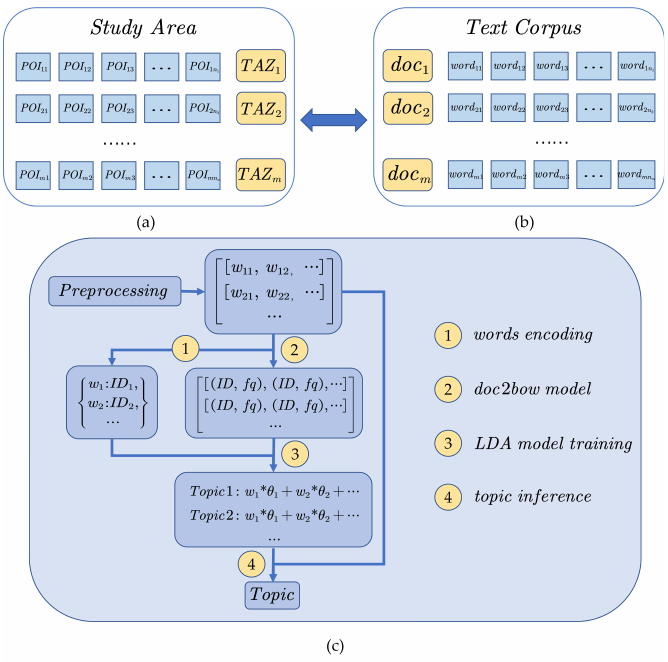
Figure 4. Semantic metrics calculation: ( a , b ) represent the analogy between the semantic calculation of the functional zone and the process of text topic inference; ( c ) is the flow chart of the topic model. In subgraph ( c ), “ w ”represents “word”, ” fq ” represents “word frequency”, “ θ ” represents the distribution of words in a topic. “ ID ” corresponds to the unique identification of each word. “ LDA ” is short for “Latent Dirichlet